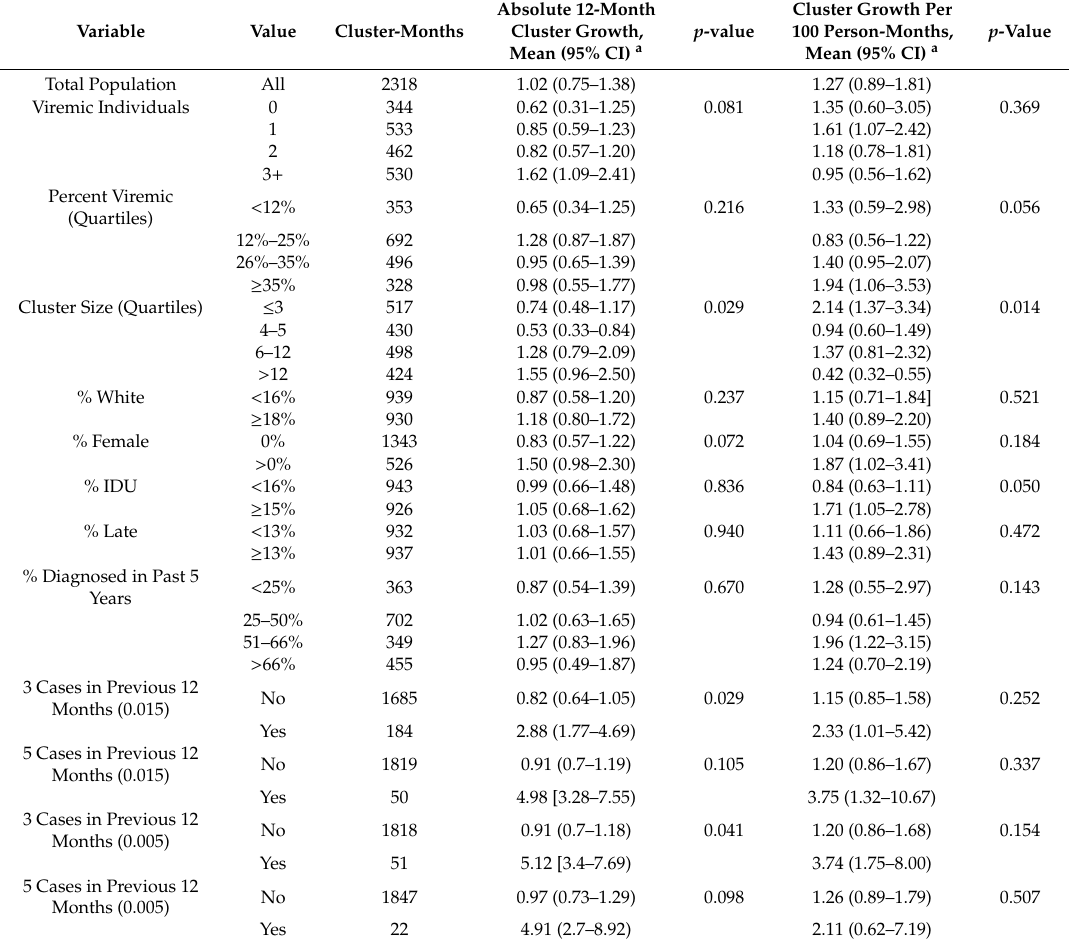
Table 5. Cluster growth rates in subsequent 12-month period by cluster attribute, Washington State 2016–2017.